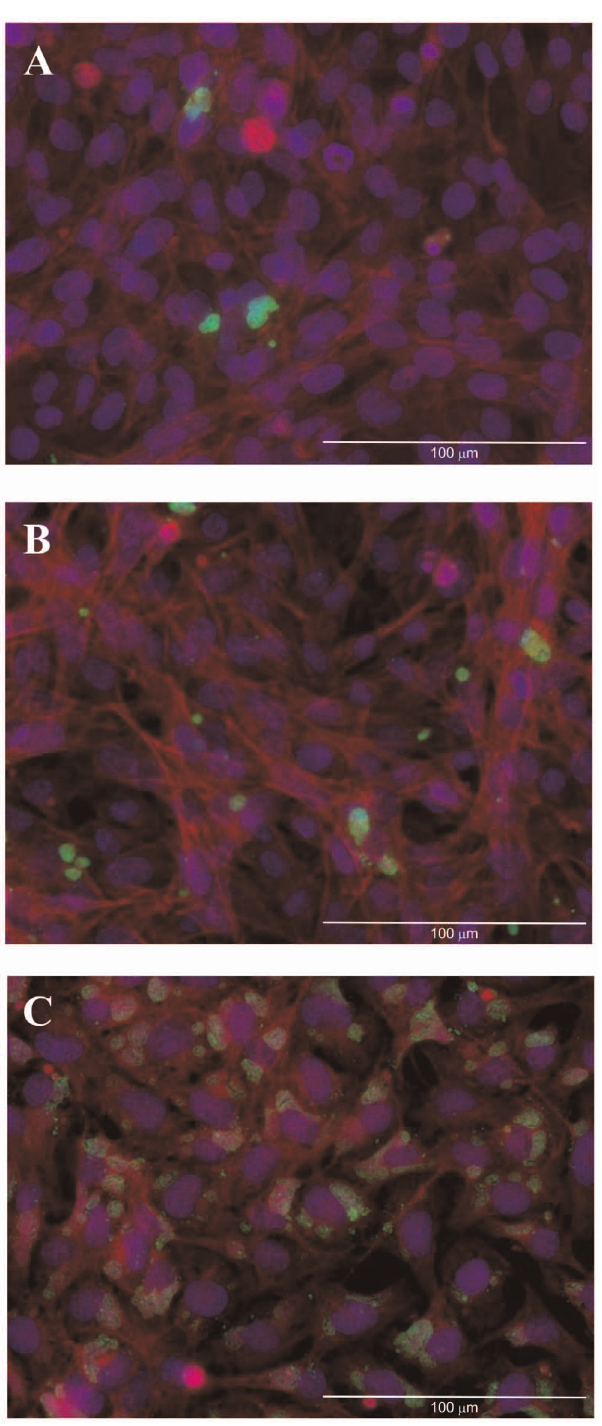
Figure 1. Fluorescent micrographs demonstrating the infectiv- ity of W.chondrophila at an apparent MOI of 0.1 (A), 1 (B) and 10 (C) at 24 h post-infection. W. chondrophila inclusions are labelled green using an anti- Waddlia rabbit polyclonal antisera and FITC anti- rabbit secondary antibody, host cell nuclei are stained in blue (Dapi) and host actin-filaments labelled with Phalloidin-Atto 550 (red). The scale bars correspond to 100 m m.